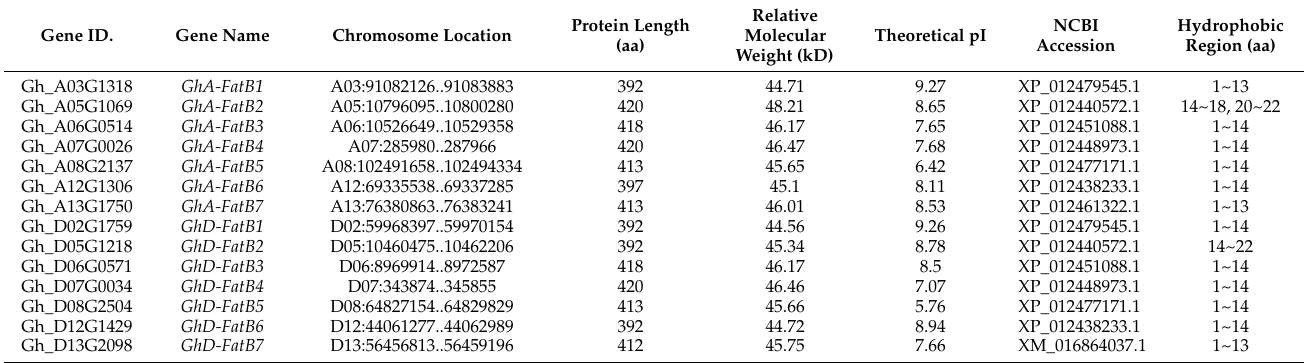
Figure 1. Fatty acid profiles of cotton seeds at three development stages (15DAF, 25DAF and 35DAF). Fatty acid level (mol%) was presented as a percentage of all fatty acids. Values are the mean ± SE of six biological duplicates. “*” and “**” represent statistically significant differences ( p < 0.05 and p < 0.01) between the fatty acid level in the 15 DAF and the value in the 25 or 35 DAF seeds, based on two-tailed Student’s t tests. Table 1. Basic information of upland cotton GhFatB